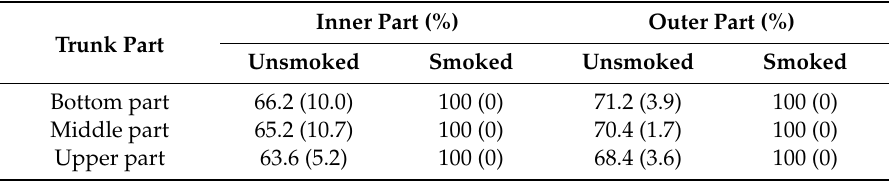
Table 6. Mortality rate of dry-wood termite.